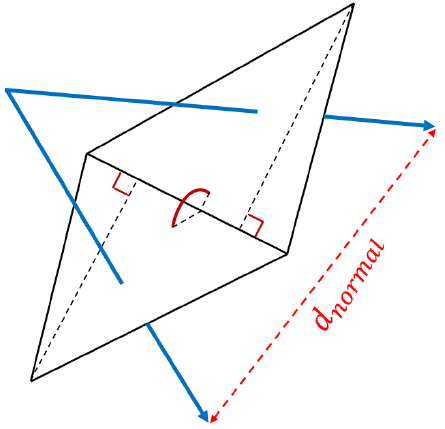
Figure 7. We use the distance of two normals to reflect the visual variance of the local surface formed by the point cloud. The blue arrows represent the normals of the two triangle meshes. d normal is the distance between the two